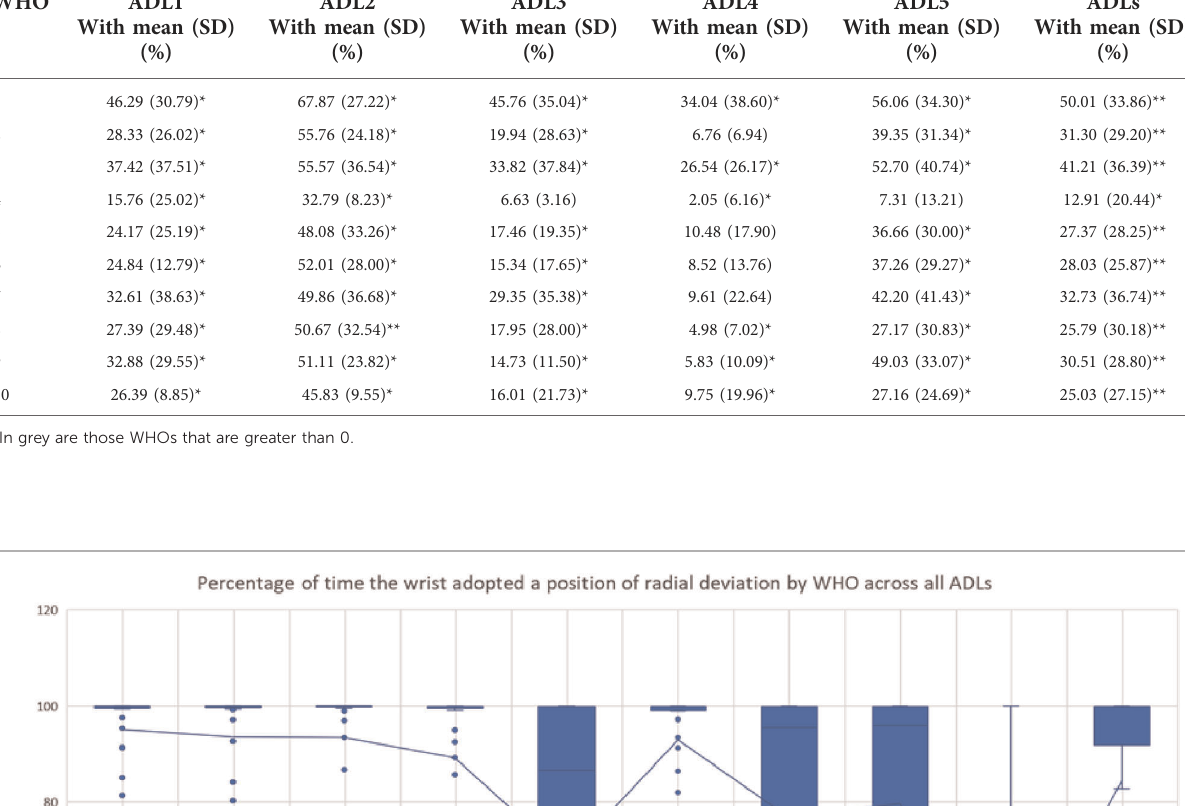
TABLE 5 Percentage of time beyond the desired range of extension (15°) by ADLs and across all ADLs, with * and ** denoting p <0.05 and p <0.001, respectively, when the percentage of time was statistically greater than 0 with WHOs (one-sample Wilcoxon signed-rank tests). a WHO ADL1 ADL2 ADL3 ADL4 ADL5 ADLs With mean (SD) (%)